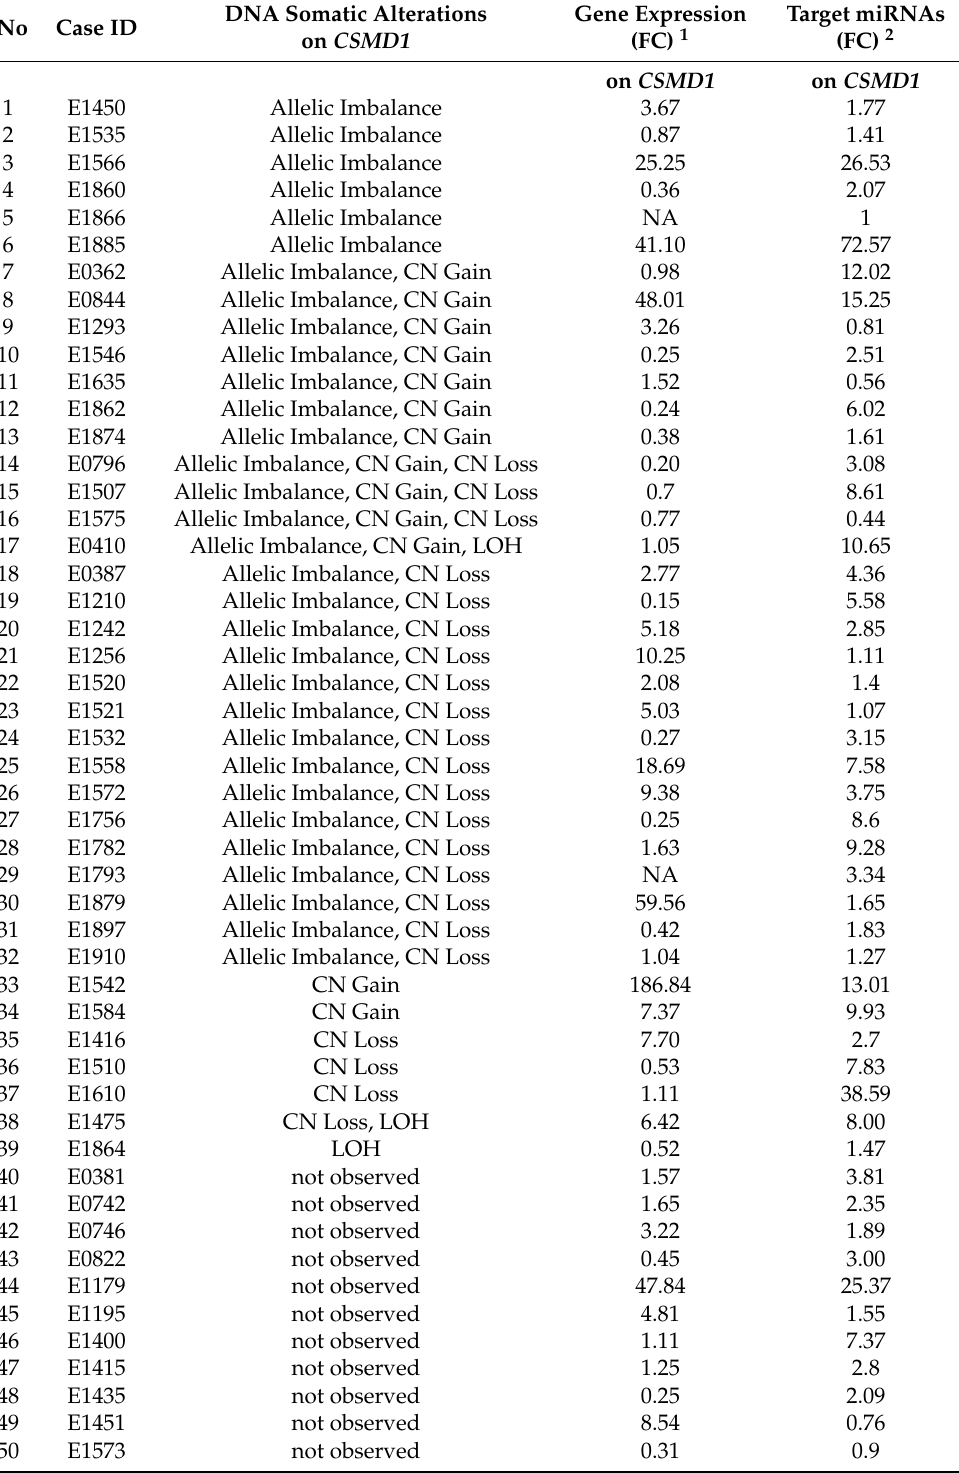
Table 1. Summary of somatic alterations and expressions of mRNA and target miRNAs on CSMD1 in 56 ESCC